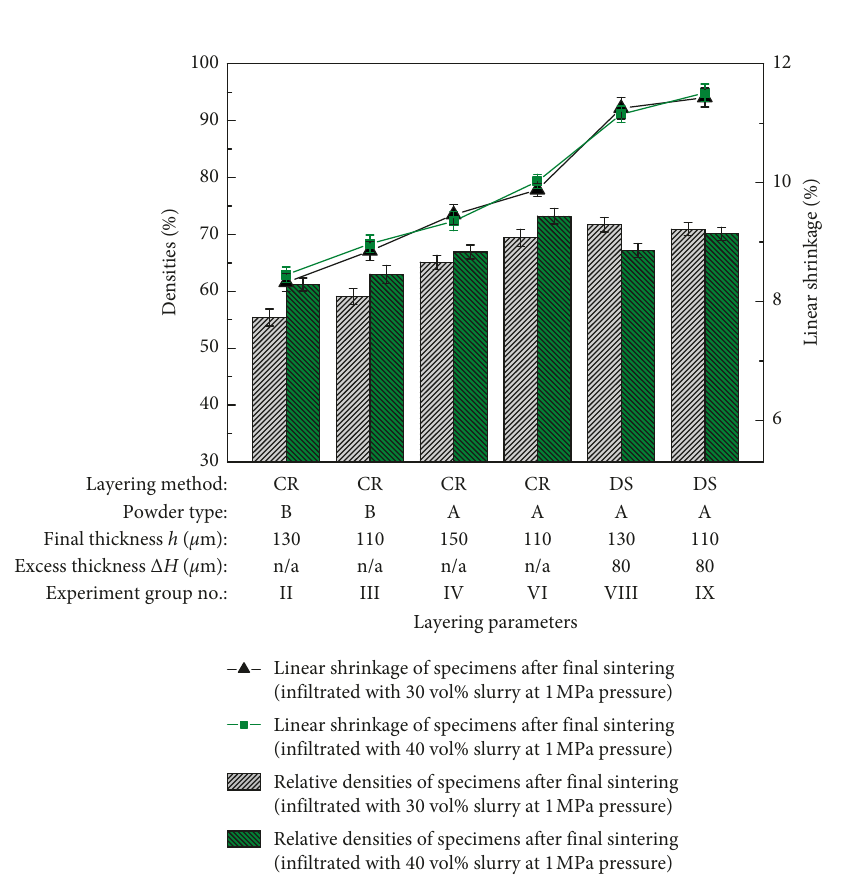
Figure 17: Variation of infiltrated specimens’ densities through final sintering. (a) Specimens infiltrated with 30 vol% slurry. (b) Specimens infiltrated with 40 vol%